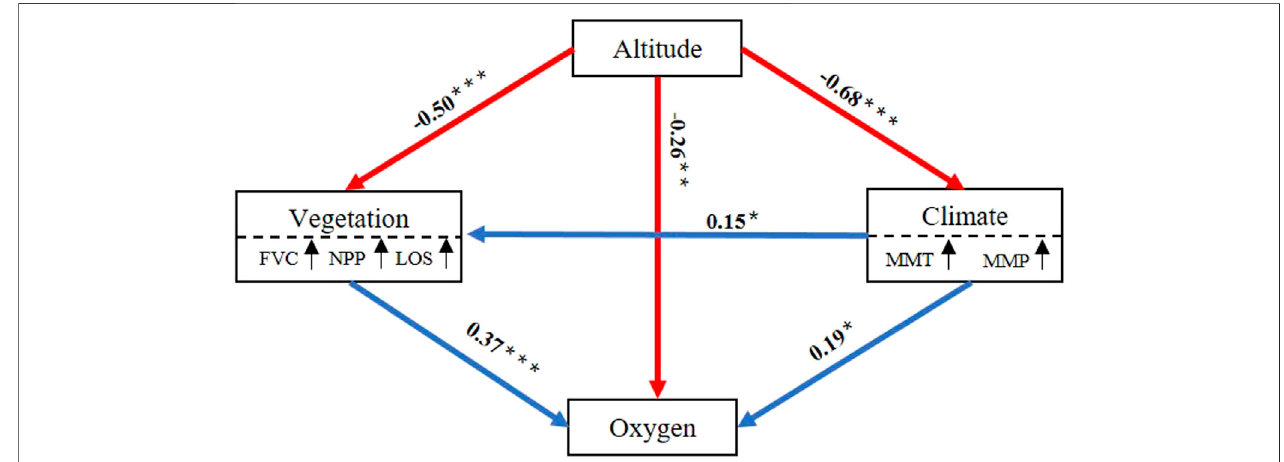
FIGURE 4 | Partial least squares path modelling (PLS-PM) analysis showing the direct and indirect effects of altitude, climate, and vegetation on oxygen content. Blue and red solid arrows indicate positive and negative associations, respectively. Numbers adjoining the arrows indicate signi fi cant standardized path coef fi cients. Climatic factors include mean monthly precipitation (MMP) and mean monthly temperature (MMT). Vegetation factors include fractional vegetation cover (FVC), net primary productivity (NPP), and length of the growing season (LOS). *, p < 0.05; **, p < 0.01; ***, p <